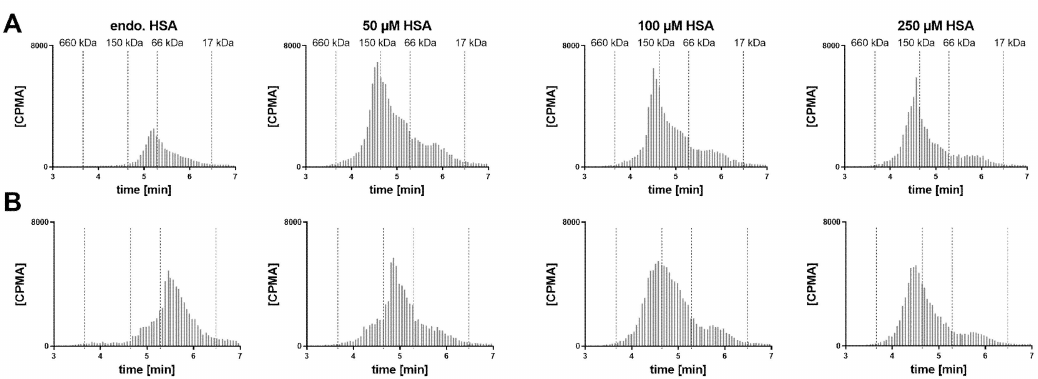
Figure 5. Radio-size exclusion chromatograms of FabA–CSA complexes formed after 4 h incubation in cynomolgus monkey VH supplemented with albumin. Two di ff erent concentrations of FabA were tested, namely ( A ) 0.6 and ( B ) 6 µ M. Endogenous albumin concentrations were supplemented with 50, 100 and 250 µ M of CSA.